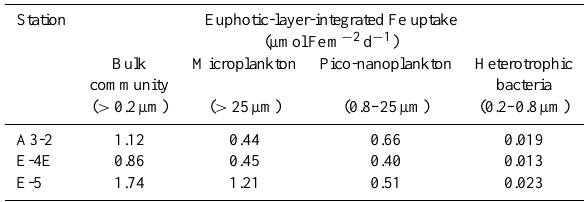
Table 4. Euphotic-layer-integrated Fe uptake of the bulk commu- nity and three size fractions. The depth of the euphotic layer is 39m for A3-2, 80m for E-4E and 41m for